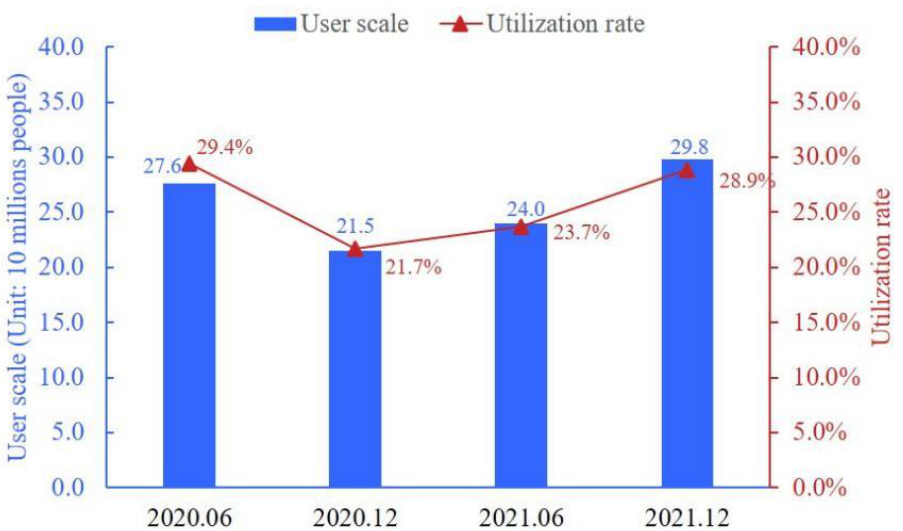
Figure 1. Scale and utilization rate of online medical users. Online Health Communities (OHCs) refer to the virtual communities whose